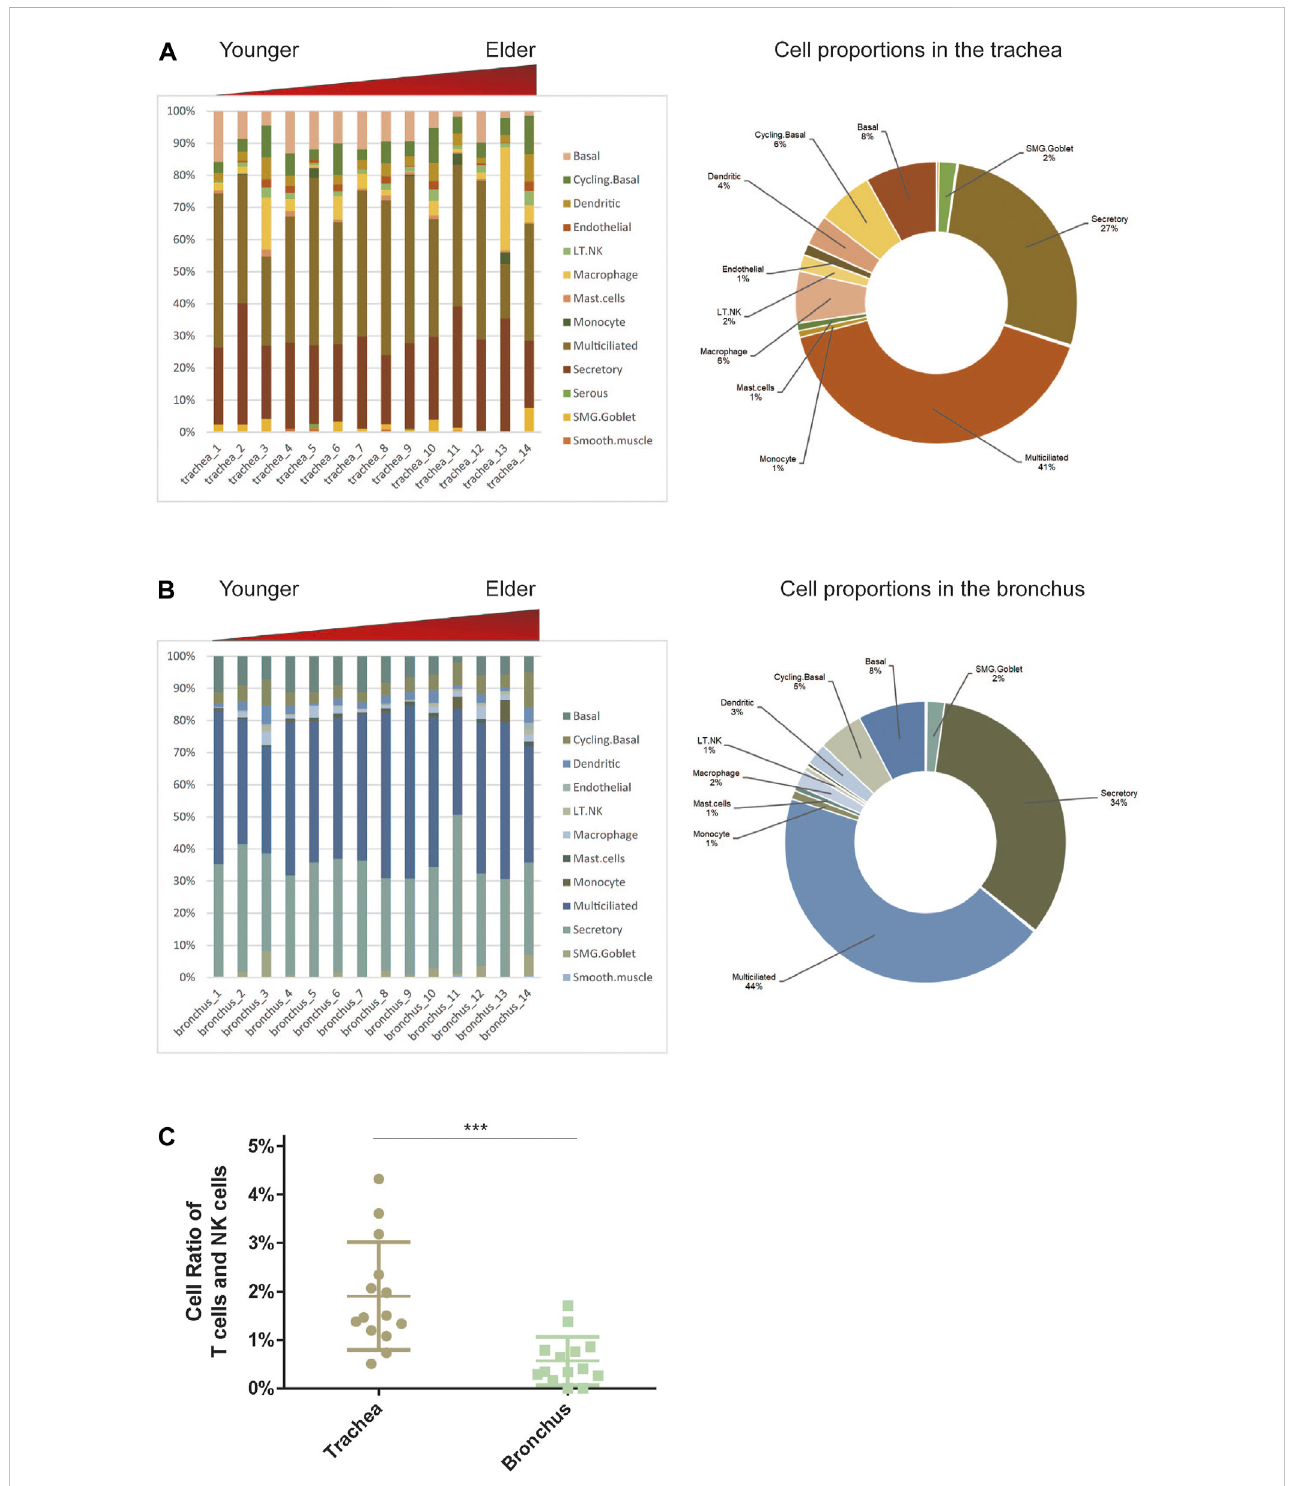
FIGURE 2 Estimate cell compositions in airway brushings using CIBERSORTx. (A) Trachea. (B) Bronchus. Notes: Cell type proportion in each sample (left), average cell type proportion (right). AT1 for type I pneumocytes; AT2 for type II pneumocytes; LT.NK for T lymphocytes and natural killer (NK) cells; PNEC for pulmonary neuroendocrine cells; SMG.Goblet for submucosal gland goblet. (C) The different cell ratios of T cells and NK cells in the trachea and bronchus. *** p <